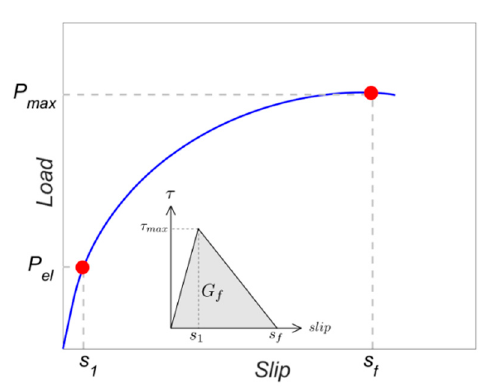
Figure 11. Bond–slip law parameters obtained from the load–slip curve for 7.5 mm grooved specimens.